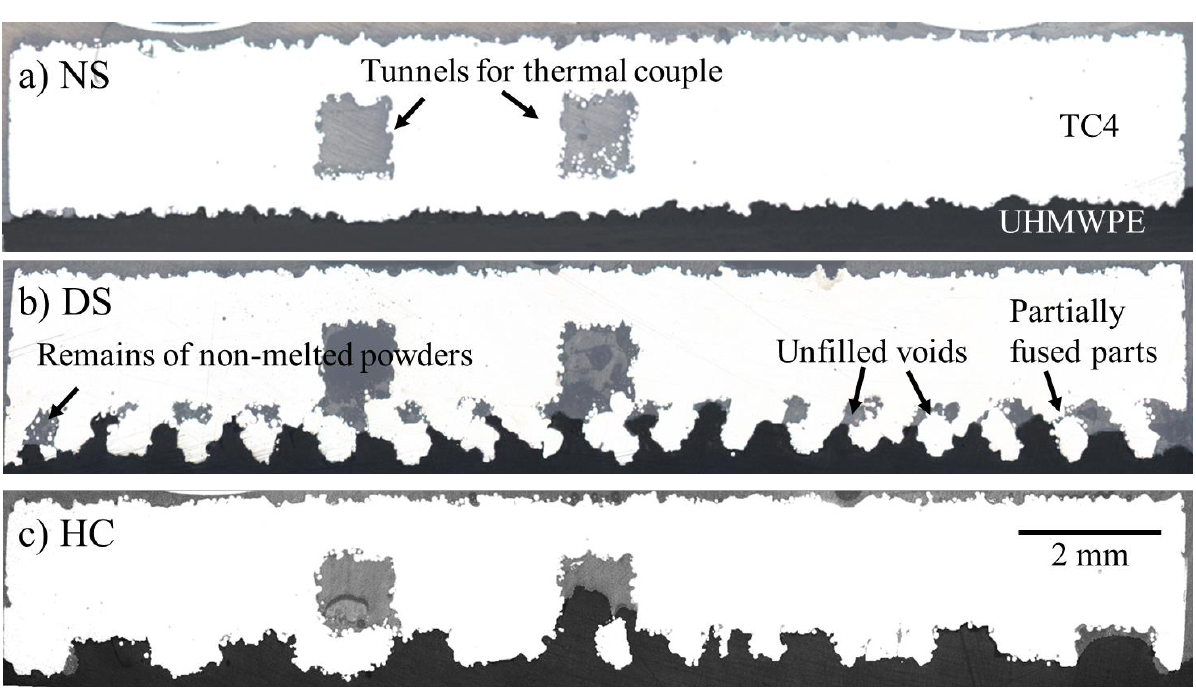
Figure 5. Interfacial macroscale morphologies of TC4–UHMWPE joints with different surface structures: ( a ) non-structured (NS); ( b ) diamond-shaped (DS); ( c ) honeycomb (HC).